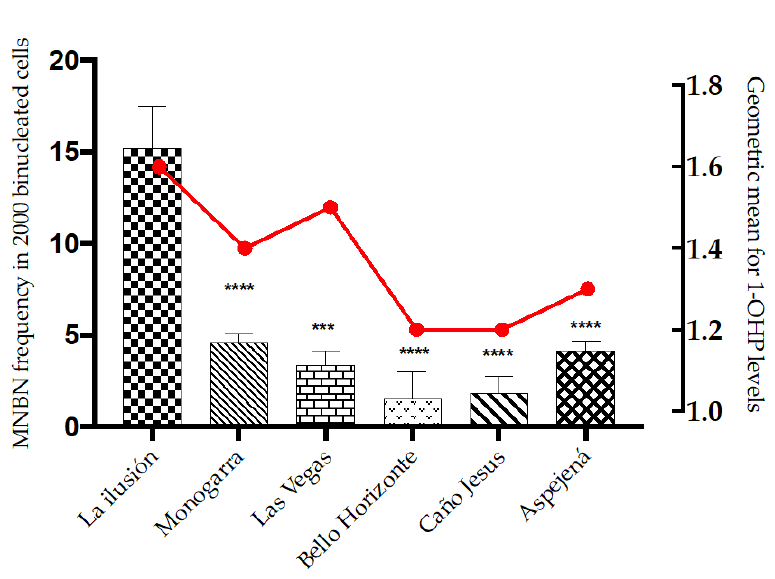
Figure 5. MN frequencies (bars) and 1-OHP levels (line chart) in Hitnü settlements included in the study. *** p ≤ 0.001; **** p ≤ 0.0001 .